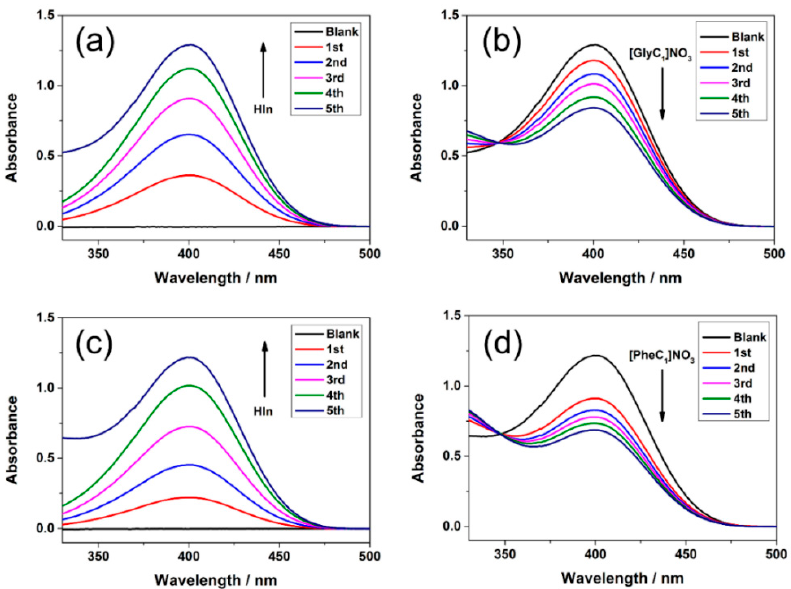
Figure 1. Absorption spectra of 4-nitrophenolate anion for various adding amounts of the indicator or [AAE]X during the titration in water. ( a ) Adding the indicator before the titration of [GlyC 1 ]NO 3 . ( b ) Adding [GlyC 1 ]NO 3 during the titration. ( c ) Adding the indicator before the titration of [PheC 1 ]NO 3 . ( d ) Adding [PheC 1 ]NO 3 during the titration. Table 1. The acid dissociation constant (p K a ) values of [AAE]X and the contrastive compounds in water.